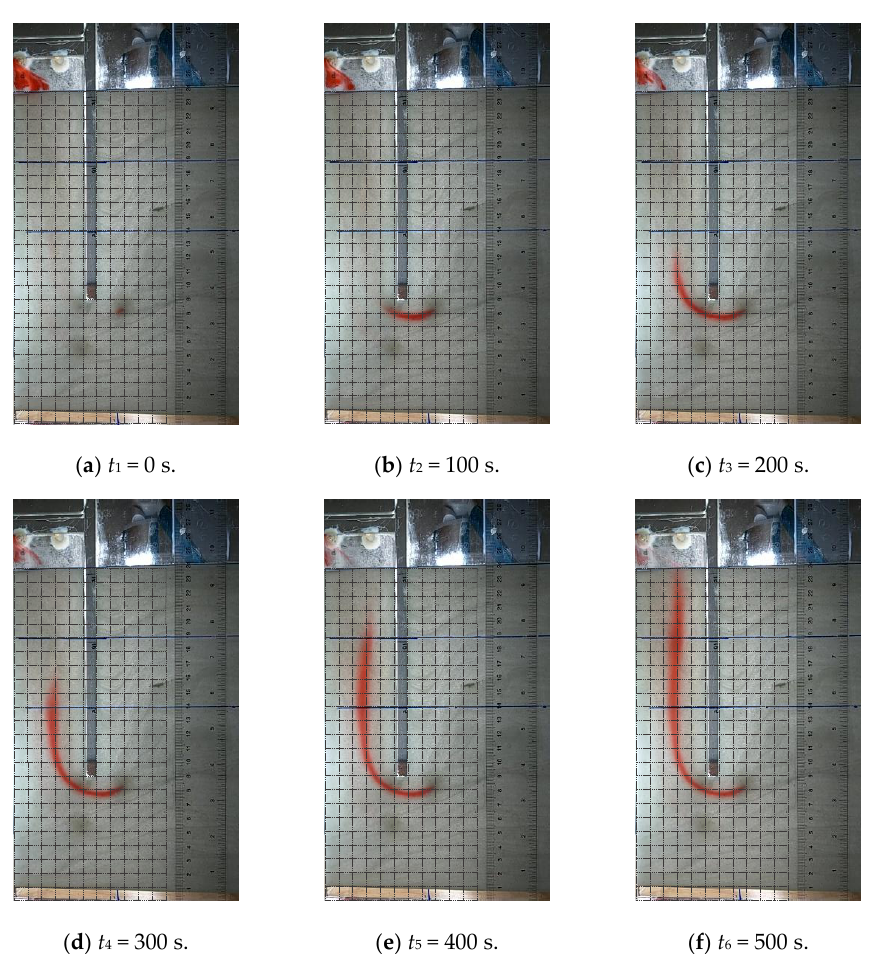
Figure 3. The visualization of seepage flow at point B with h = 15 cm and S = 0.5 kPa.